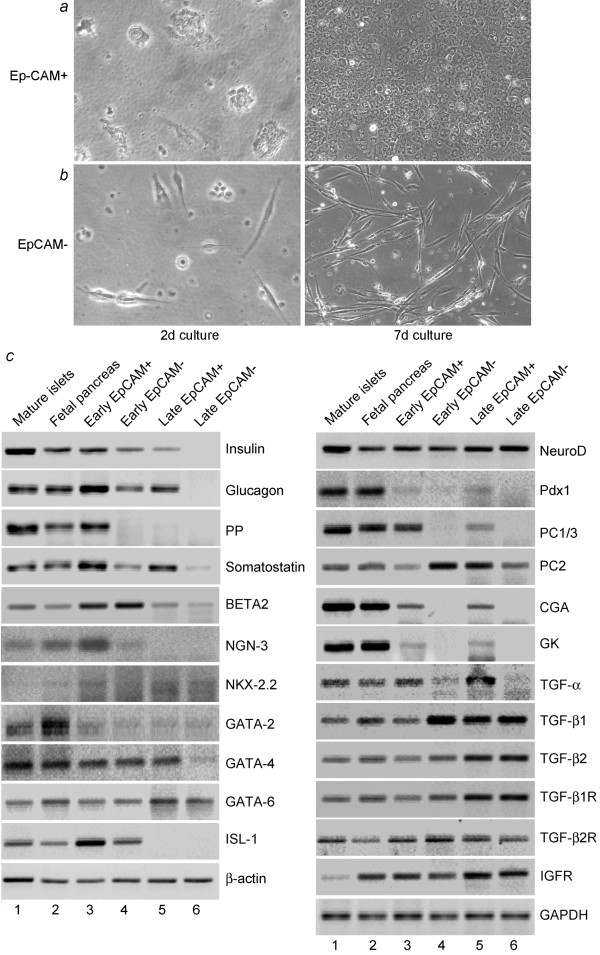
Initial characterization of fetal pancreatic cells. (a) and (b) show morphology of cells in culture after 2 d and 7 d. Note epithelial morphology of EpCAM-positive cells. (c) shows RT-PCR for genes as indicated. Lanes 1 to 6 show results from mature human pancreatic islets, intact fetal pancreas, cells after early term culture (1 to 2 d) or longer culture (10 to 14 d). For comparisons, β-actin and glyceraldehyde phosphate dehydrogenase (GAPDH) genes were included.